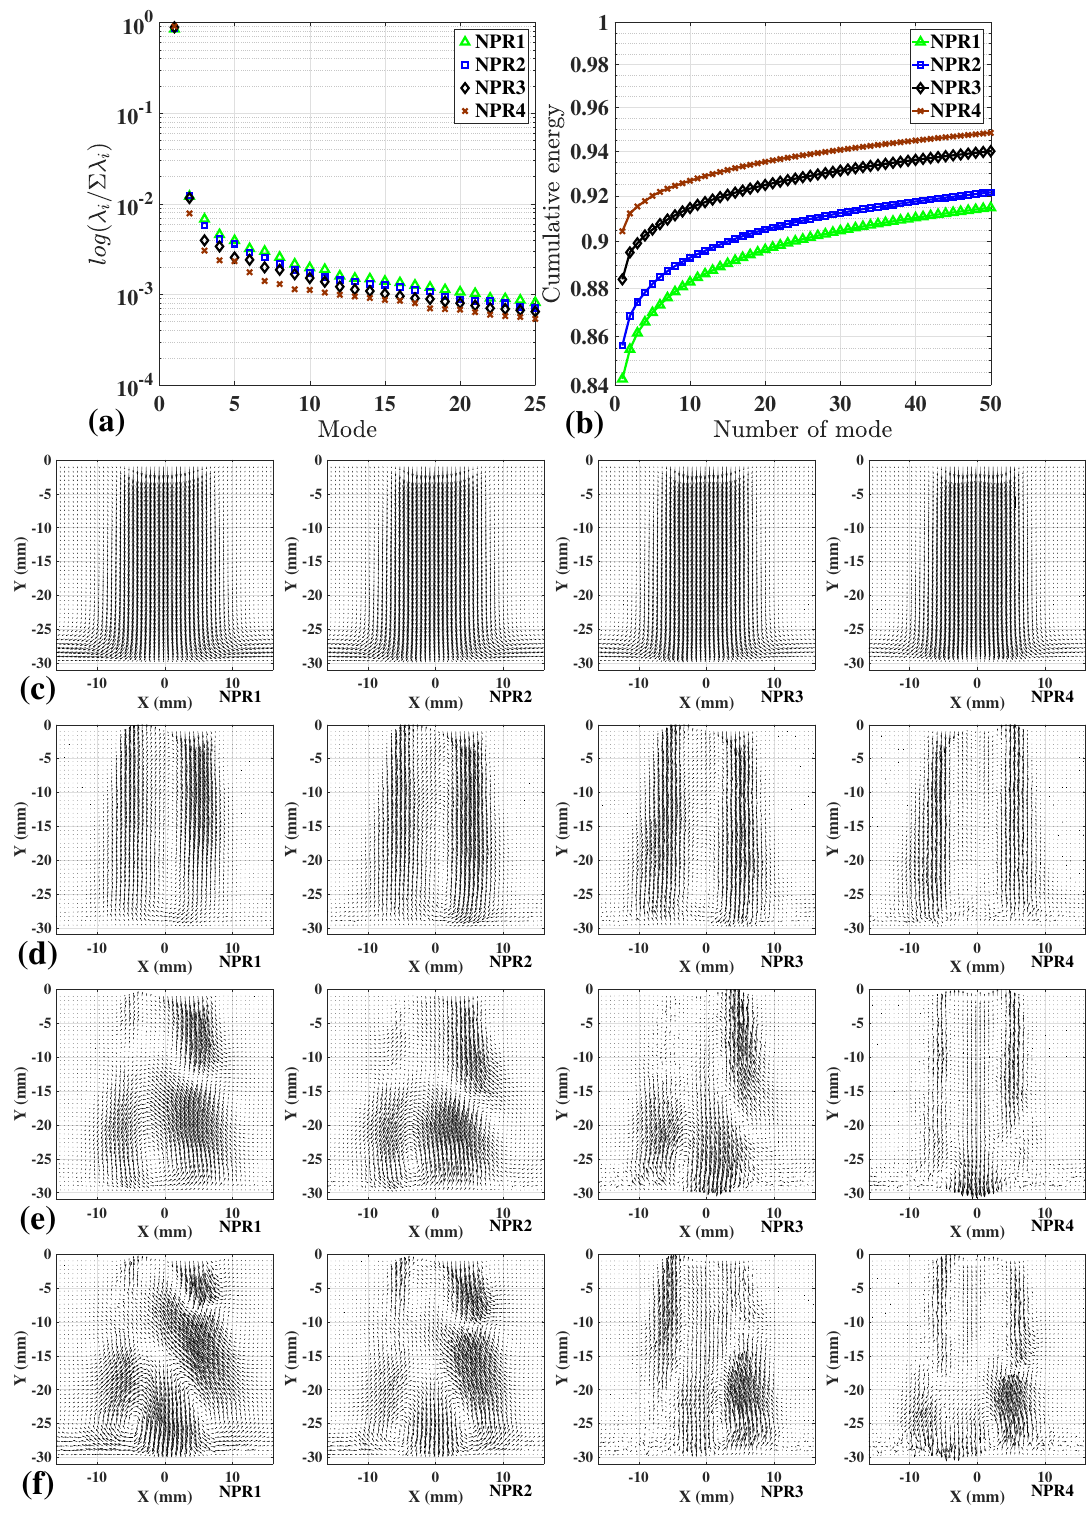
Figure 11. POD analysis of the velocity fields obtained from the 2D2C PIV measurements of under-expanded impinging jets with e = 30 mm ( e / D j = 2.46) for NPR 1 = 2, NPR 2 = 2.2, NPR 3 = 2.5, and NPR 4 = 2.77 ( a ) Kinetic energy spectra; ( b ) cumulative energy. Low-order POD velocity modes ( c ) Psi 1 , ( d ) Ψ 2 , ( e ) Ψ 3 , and ( f ) Ψ 4 . Vectors were de-sampled for better